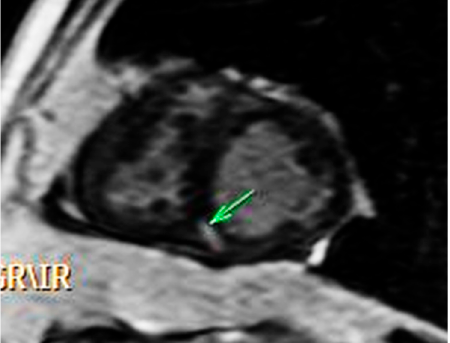
Figure 4. Pulmonary CTA: ( a ) 3D reconstruction and ( b ) MIP reconstruction: abdominal aortopul ‐ monary collateral vessels; ( c ) 3D reconstruction: thoracic aortopulmonary collateral vessels; ( d ) axial section: the main pulmonary artery (PT) had a small caliber (10 mm, with an ascending aortic / pul ‐ monary trunk ratio of 3.6), associating a small diameter of the origin of both pulmonary arteries (10 mm on the right and 8 mm on the left).